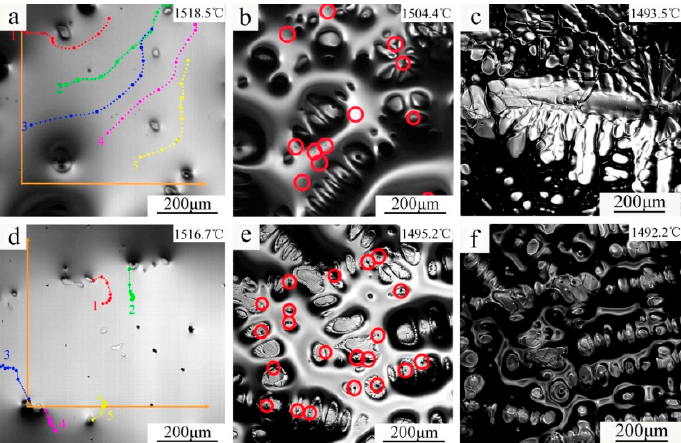
Figure 5. Motion traces of inclusions in molten steel, and five tracked inclusions marked as five numbers ( a ) without PMF and ( d ) with PMF. The distribution of particles in the last regions to solidify, and all visible inclusions marked by red circles ( b ) without PMF and ( e ) with PMF. The solidified microstructure of samples ( c ) without PMF and ( f ) with PMF.